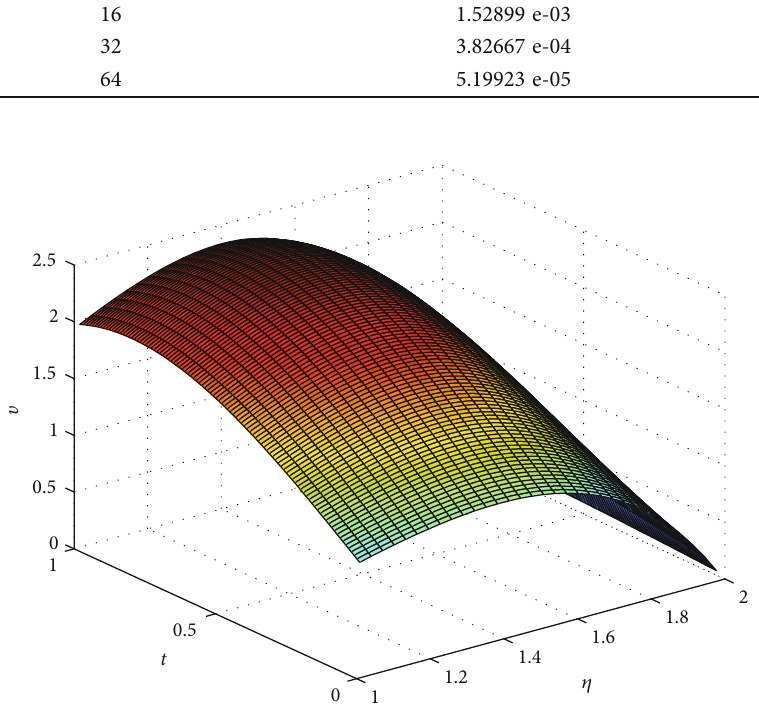
Figure 2: Graph of approximate solution for N = 32 grid points, for Example 2.